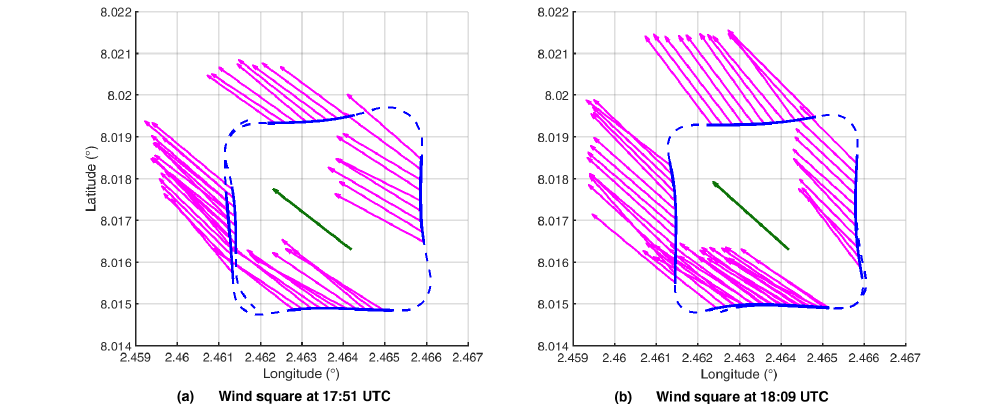
Figure 9. Two examples of wind squares flown and their determined wind vectors (only every 100th vector is shown for readability), measured on 2 July, at 17:51 and 18:09 UTC in Savè (Collines, Benin), during the DACCIWA [27] project at 100m above the ground. For the wind square in ( a ), mean wind direction was 128 ◦ and wind magnitude 2.6ms − 1 . For the wind square in ( b ), mean wind direction was 132 ◦ and wind magnitude 2.7ms − 1 . In each subfigure, the averaged wind vector is shown in dark grey.